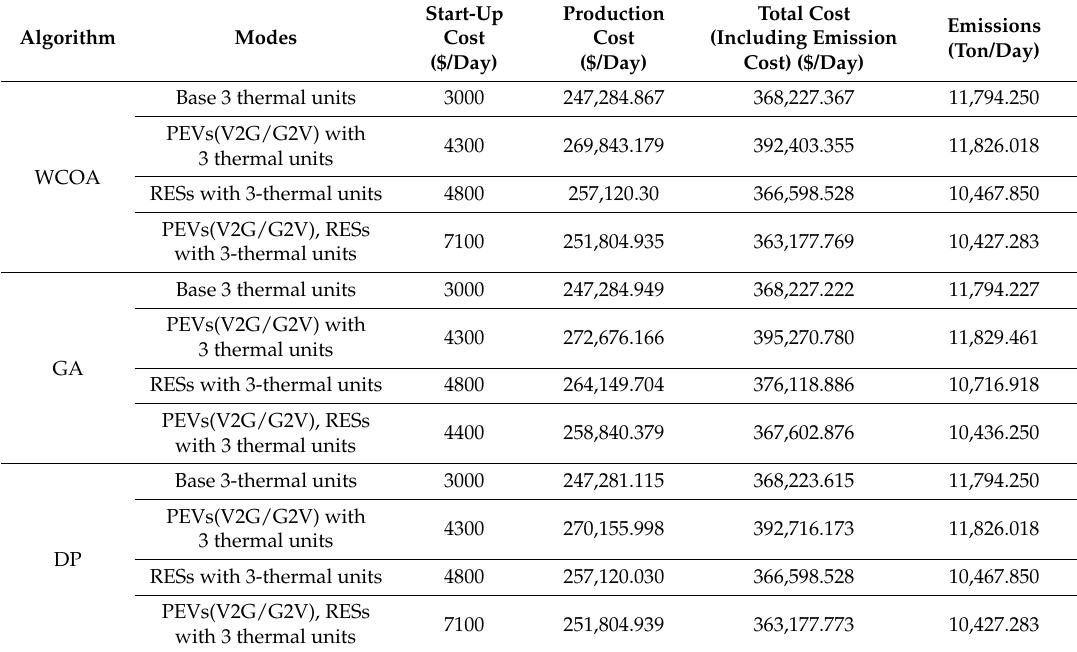
Table 9. Results summary for WCOA, GA and DP (including emission